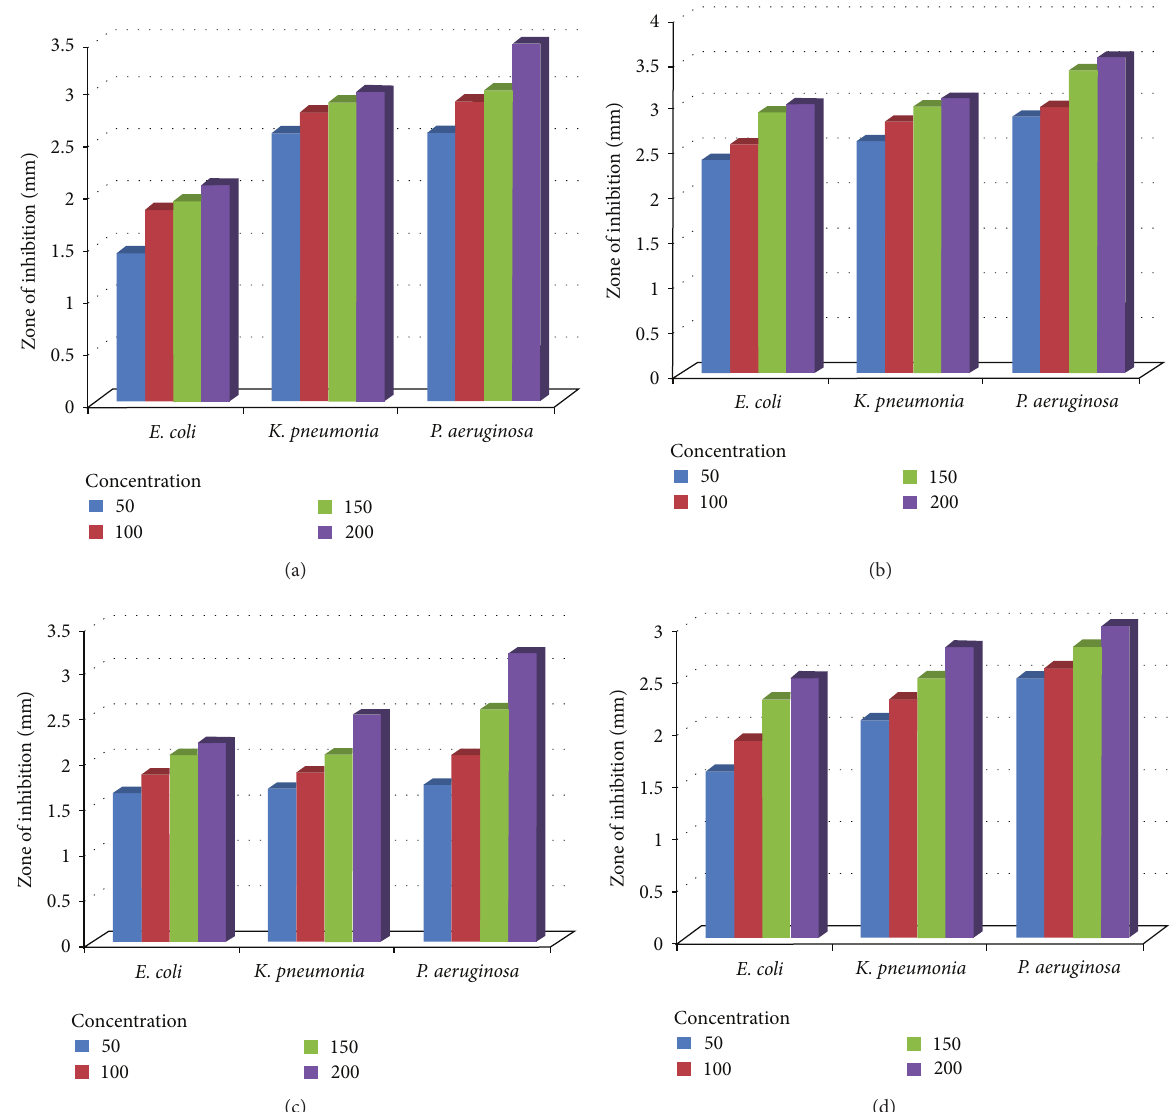
Figure 4: Comparative results of antibacterial screening data for: (a) Ciprofloxacin (drug), (b) MnCl 2 ⋅ 4H 2 O, (c) [ { ( o -CH 3 C 6 H 4 O) 2 PS 2 } 2 Mn] ( 1 ), and (d) [ { ( o -CH 3 C 6 H 4 O) 2 PS 2 } 2 Mn ⋅ N 2 C 12 H 8 ] ( 5 ). all the complexes inhibited the growth of fungus